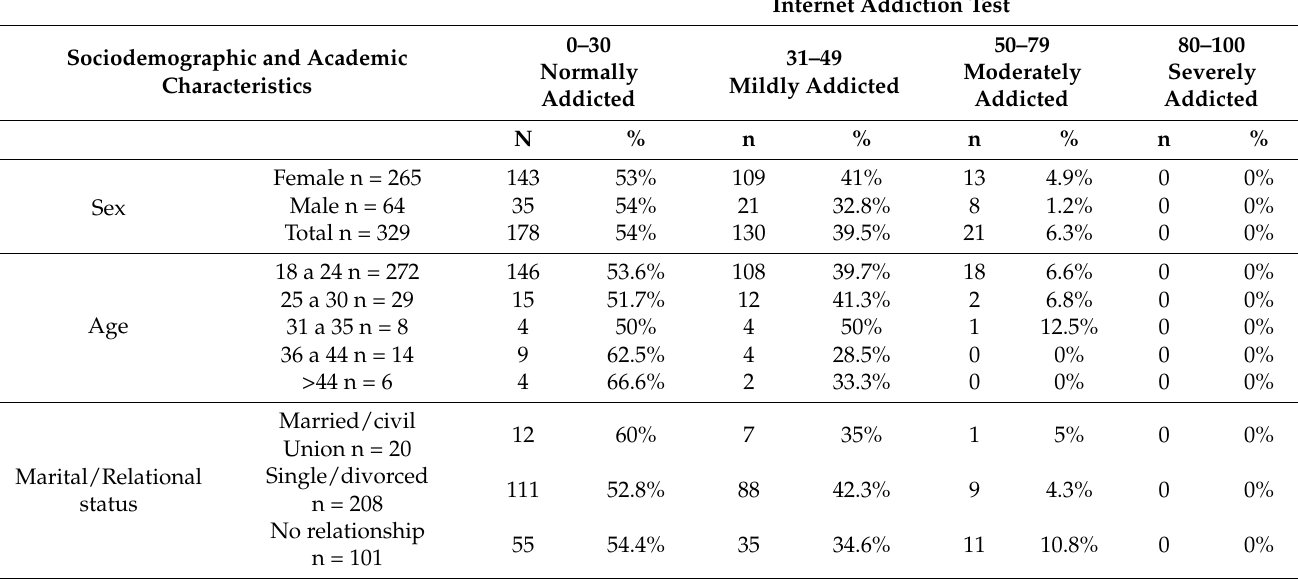
Table 3. Sociodemographic of the sample and the values of Internet Addiction